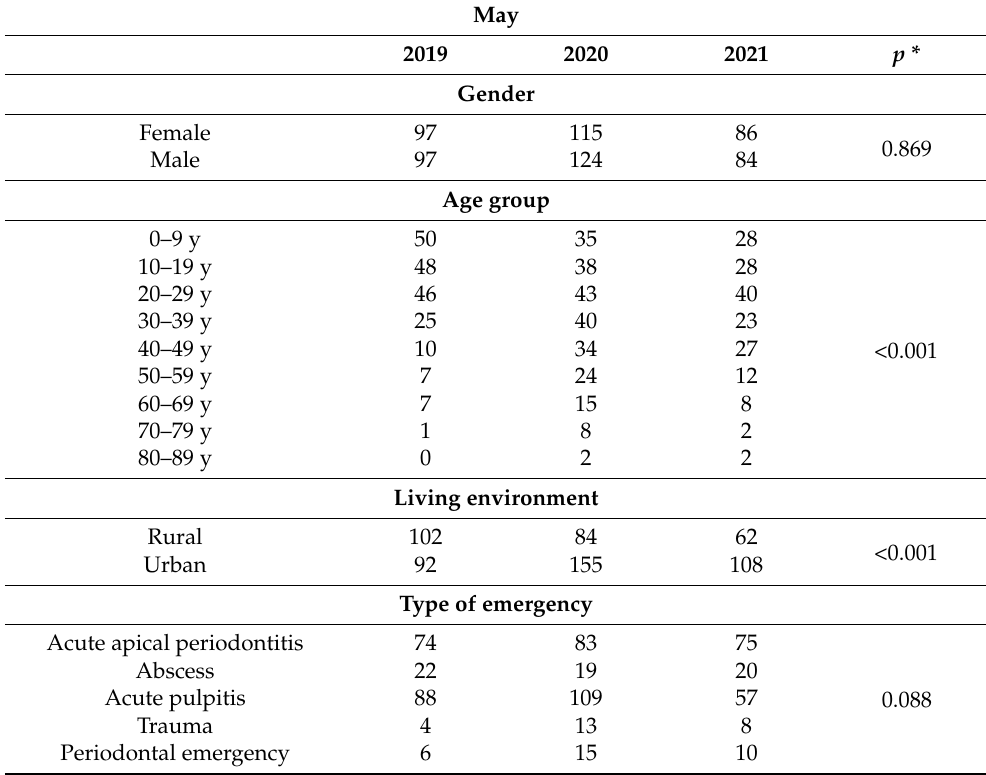
Table 5. Evolution for May 2019, 2020, and 2021 according to the investigated